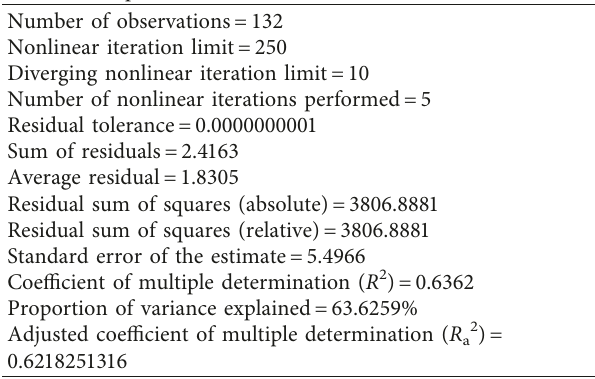
Table 4: Multifactorial nonlinear regression analysis values for model